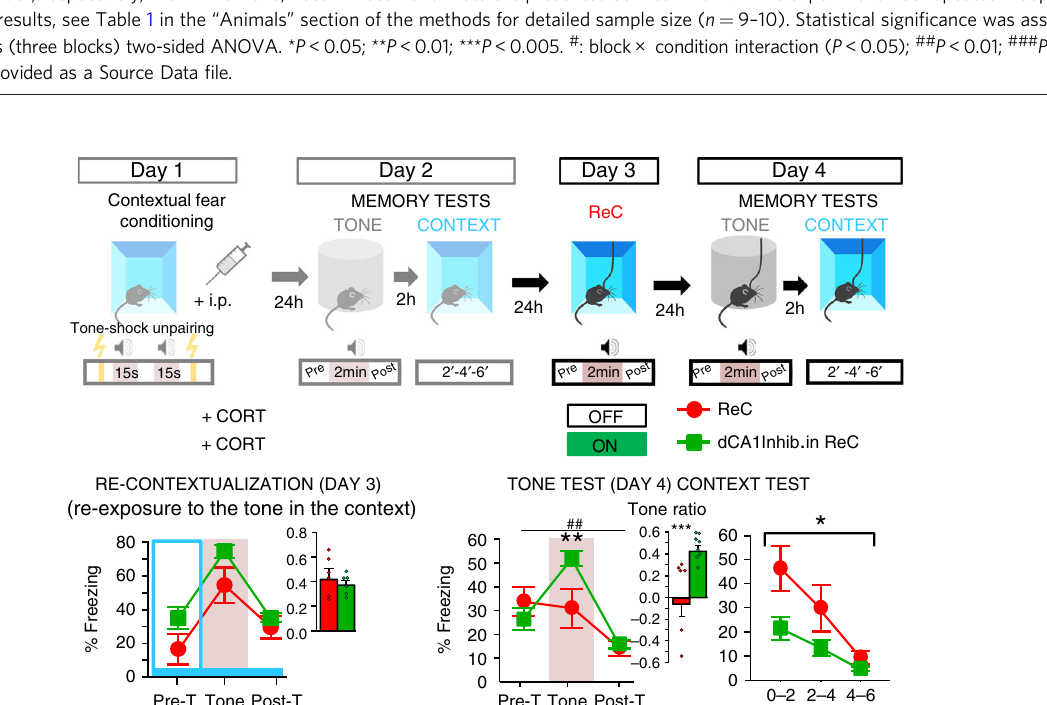
Fig. 2 Switching from PTSD-like memory to normal fear memory by trauma re-contextualization. Top panel, scheme illustration of the behavioral procedure: fear conditioning (Day 1), memory tests (Day 2), trauma re-contextualization by complete re-exposure to trauma-related cues (i.e. to the tone